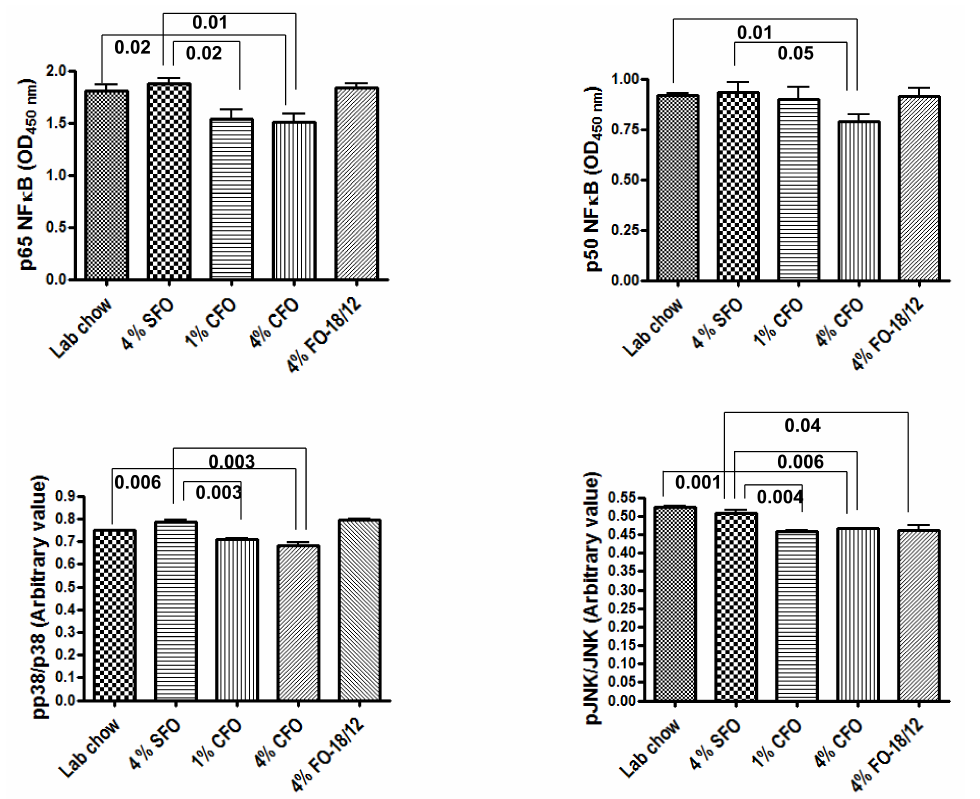
Figure 5. CFO suppresses RANKL-stimulated activation of NF-kB, p38 MAPK, and JNK signaling. Twelve-months-old C57Bl / 6 mice were fed experimental diets for 12 months. Twenty-four-months-old mice were then sacrificed, and bone marrow cells were isolated and cultured in 24 well plates in the presence of 30 ng / mL MCSF for three days and then stimulated with 50 ng / mL RANKL for 30 minutes, and then nuclear proteins were prepared. 10 µ g of nuclear proteins were analyzed for p65 NF-kB and p50 NF-kB-DNA binding activity using TransAM Transcription Factor Assay kit. Activation of p38 and JNK were analyzed using in cell Western phosphor ELISA system. Bone marrow cells are isolated and cultured in 96 well plates in the presence of MCSF for three days, followed by stimulation with RANKL for 30 minutes and analyzed for the total and phosphor protein levels according to the manufacturer’s instructions. Phospho and total proteins were normalized with cell density according to the manufacturer’s instructions. Then phosphoprotein levels were normalized with total protein levels. Each value represents the mean ± S.E.M. of two independent triplicate cultures. P -value < 0.05 was considered significant by Student’s t-test. SFO, sa ffl ower oil containing 70%–80% ω -6 linoleic acid; CFO, concentrated fish oil containing 46.5% EPA and 37.5% DHA; FO-18 / 12, regular fish oil containing 18% EPA and 12%